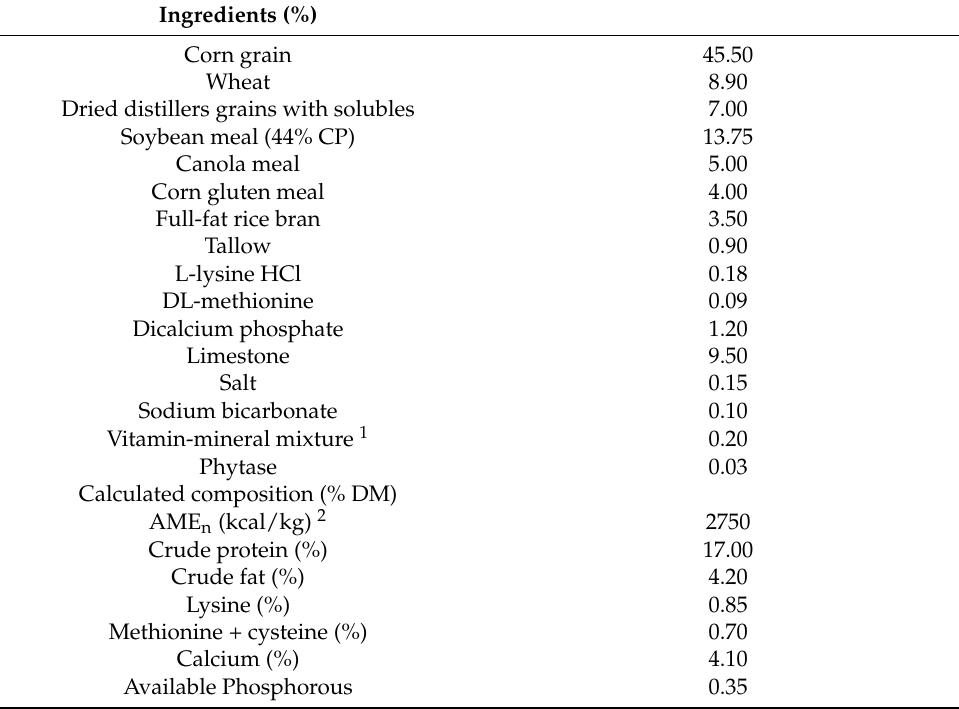
Table 1. Formula and chemical composition of layer